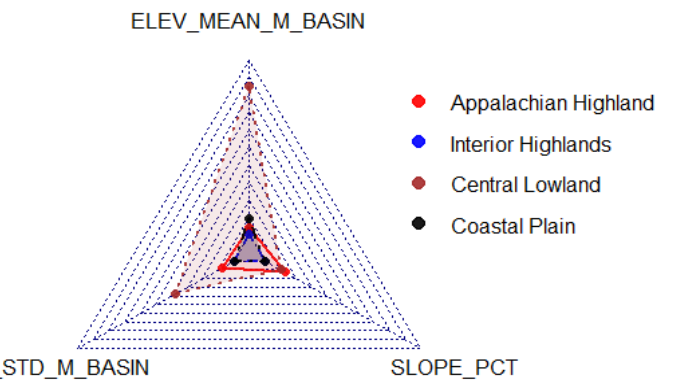
Figure 10. Comparison of importance levels for soil variables (ranking 1 to 10) common to more than one region.